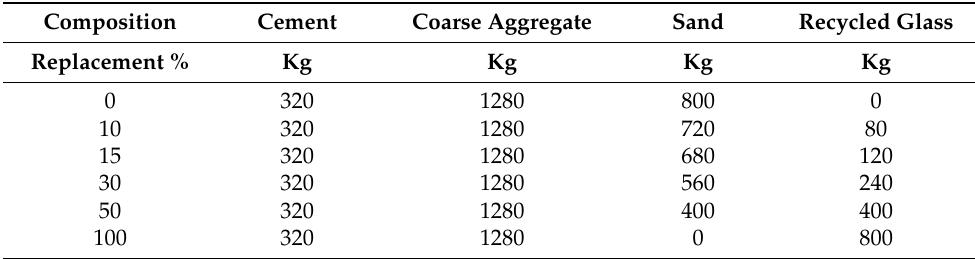
Table 1. Mix proportion in batches for the various crushed waste glass (CWG) substitutions 32-MPa concrete.